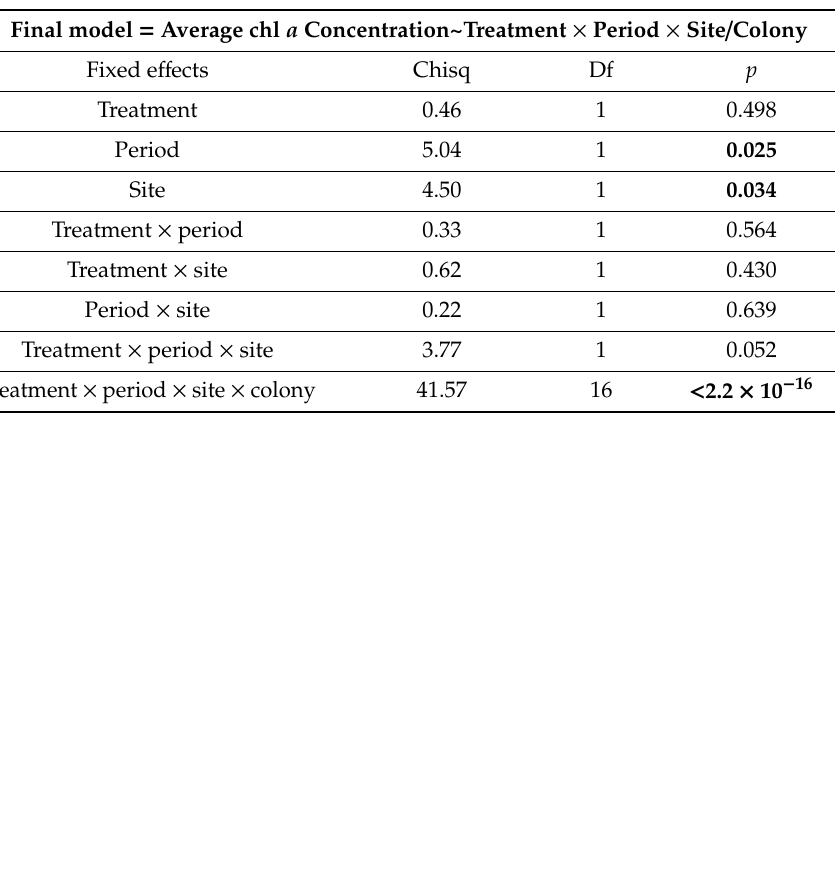
Table 3. Results from linear mixed model analysis for changes in chl a concentration in response to individual factors (treatment, period, site, colony) and interaction between these factors. Significant values are in